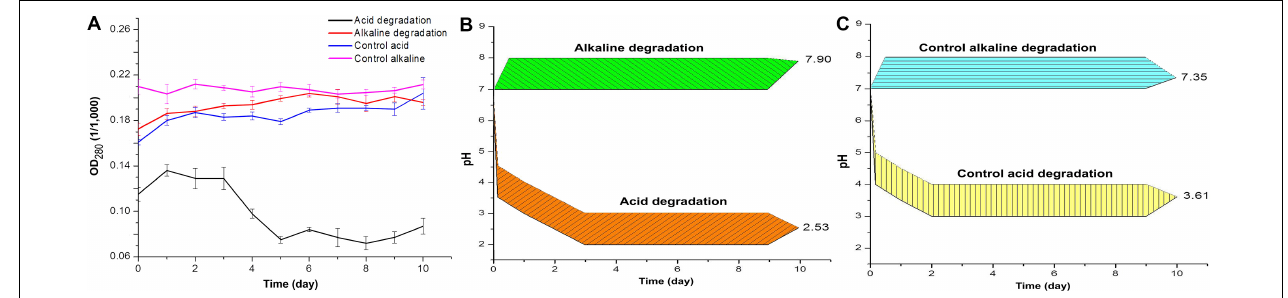
FIGURE 1 | (A) Optical density of acid and alkaline-biodegraded lignin and controls at 280 nm. (B) pH measures of acid and alkaline-biodegraded lignin and (C) pH measures of controls. The range of the pH measures is ± 0.50.